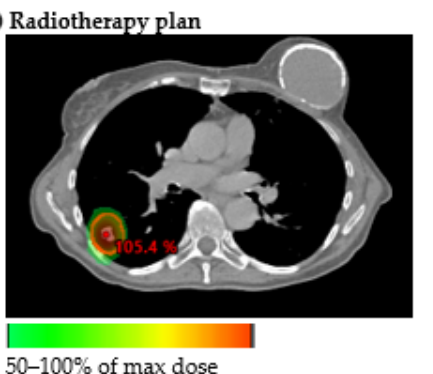
Figure 3. Correlation of ( a ) FDG-SUV max and FLT-SUV max with linear fit (R = 0.804; p < 0.001; spearman’s correlation), and ( b ) FDG-SUV peak and FLT-SUV peak with linear fit (R = 0.770; p < 0.001; spearman’s correlation).